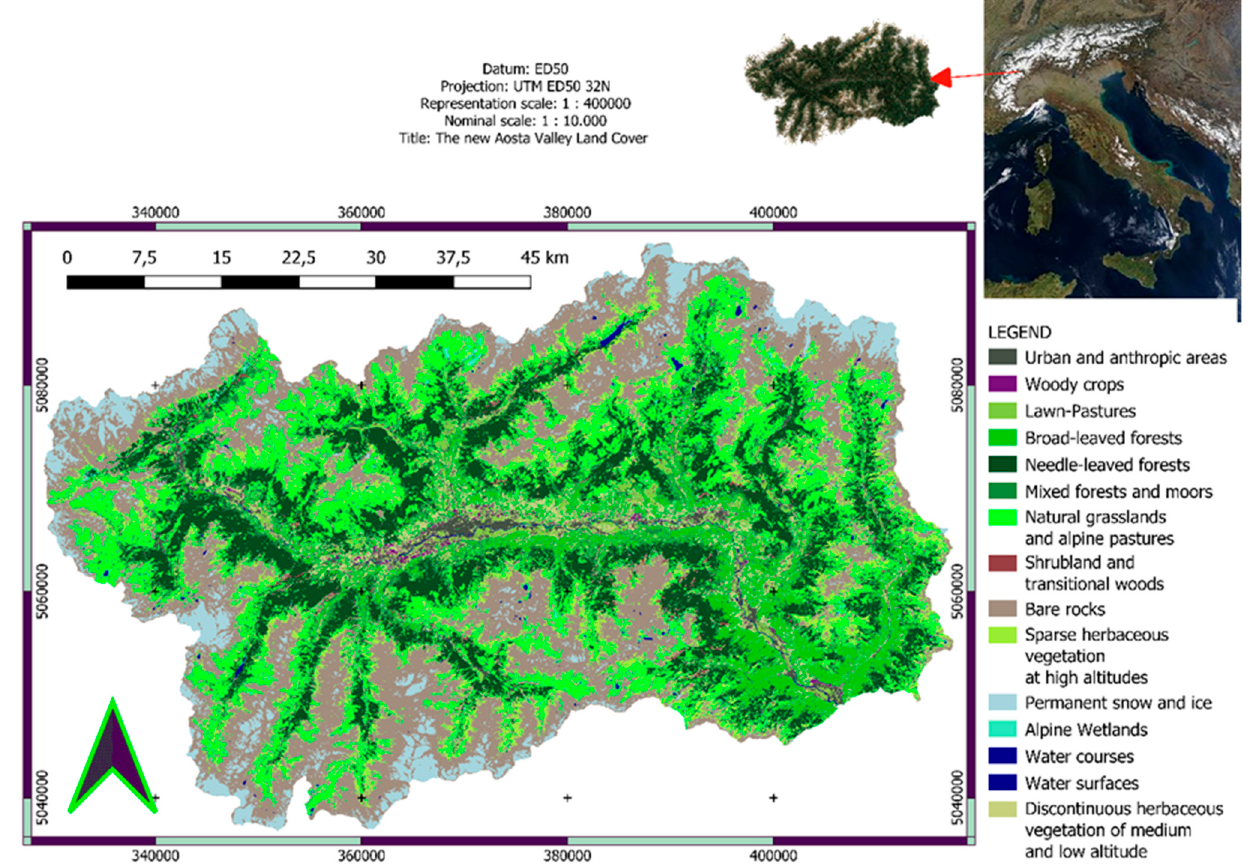
Figure 5. Aosta Valley Land Cover 2020.